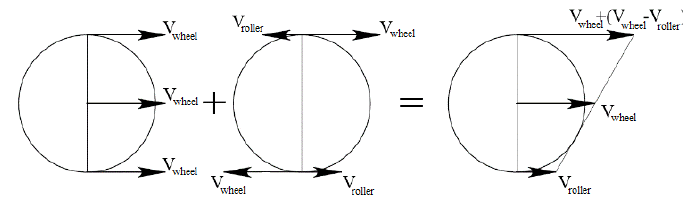
Fig. 8. Diagram of the wheel movement in the presence of slippage.